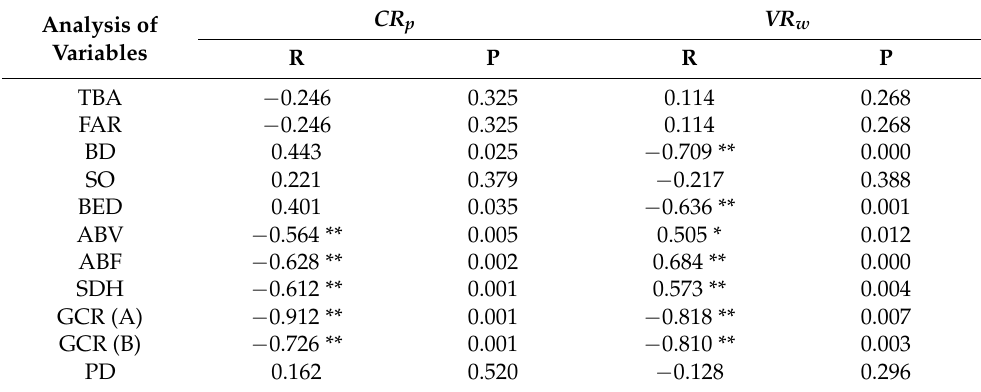
Table 4. Correlation analysis of morphological parameters with PM 2.5 and wind